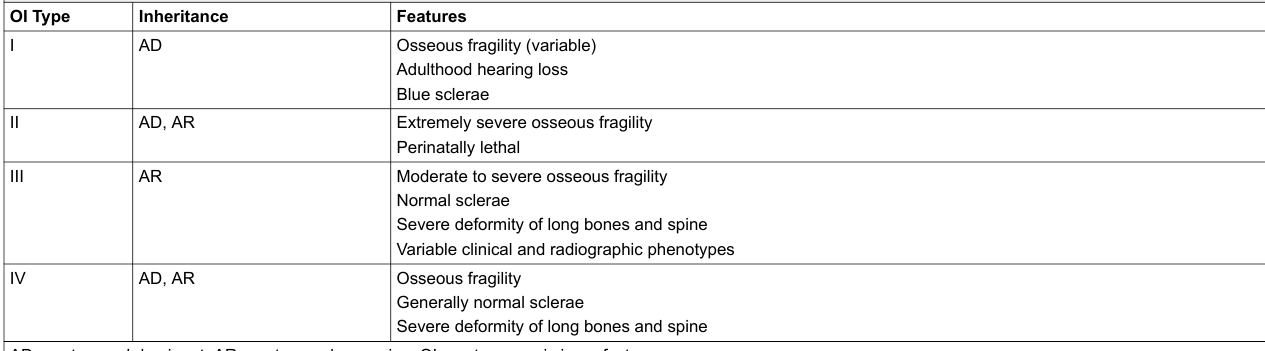
Table 1: 1979 Sillence classification of osteogenesis imperfecta.